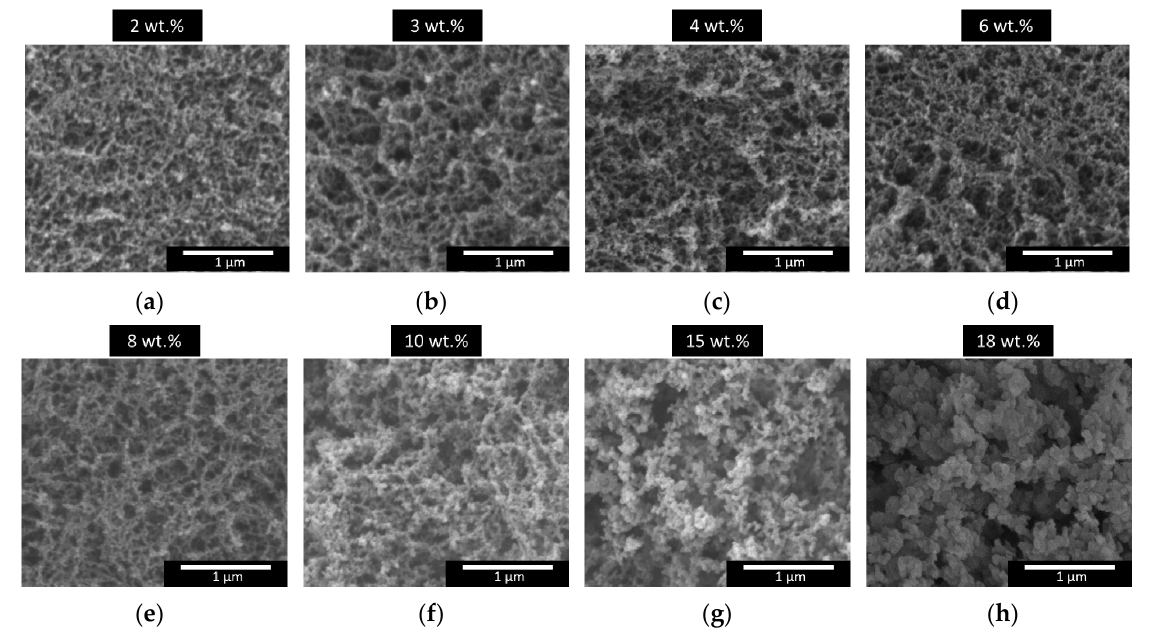
Figure 1. SEM Micrographs of the porous structures of polyisocyanurate–polyurethane (PUR–PIR) aerogels for different catalyst contents ranging from 2 to 18 wt.%, ( a ) 2wt.%, ( b ) 3 wt.%, ( c ) 4 wt.%, ( d ) 6 wt.%, ( e ) 8wt.%, ( f ) 10 wt.%, ( g ) 15 wt.% and ( h ) 18 wt.%. The particle size distribution of each sample affects the efficiency of the scattering mechanism. Figure 2 displays the particle size distribution for the content of each catalyst. Narrow distributions are obtained for those aerogels with a low catalyst content in their formulation (2, 3, 4, and 6 wt.%), which are formed by particles with a homogeneous size. In fact, almost all particles have sizes below 40 nm in these aerogels. Nevertheless, for samples containing higher catalyst amounts (8, 10, 15, and 18 wt.%), the size of the polymeric particles is more heterogeneous, covering a wider range of the nanometric scale, with a significant number of particles larger than 40 nm.